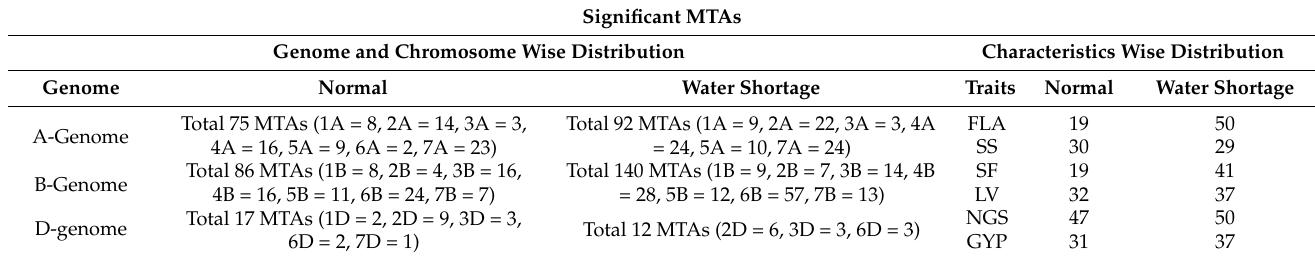
Table 5. Highest number of Significant MTAs in 105 bread wheat